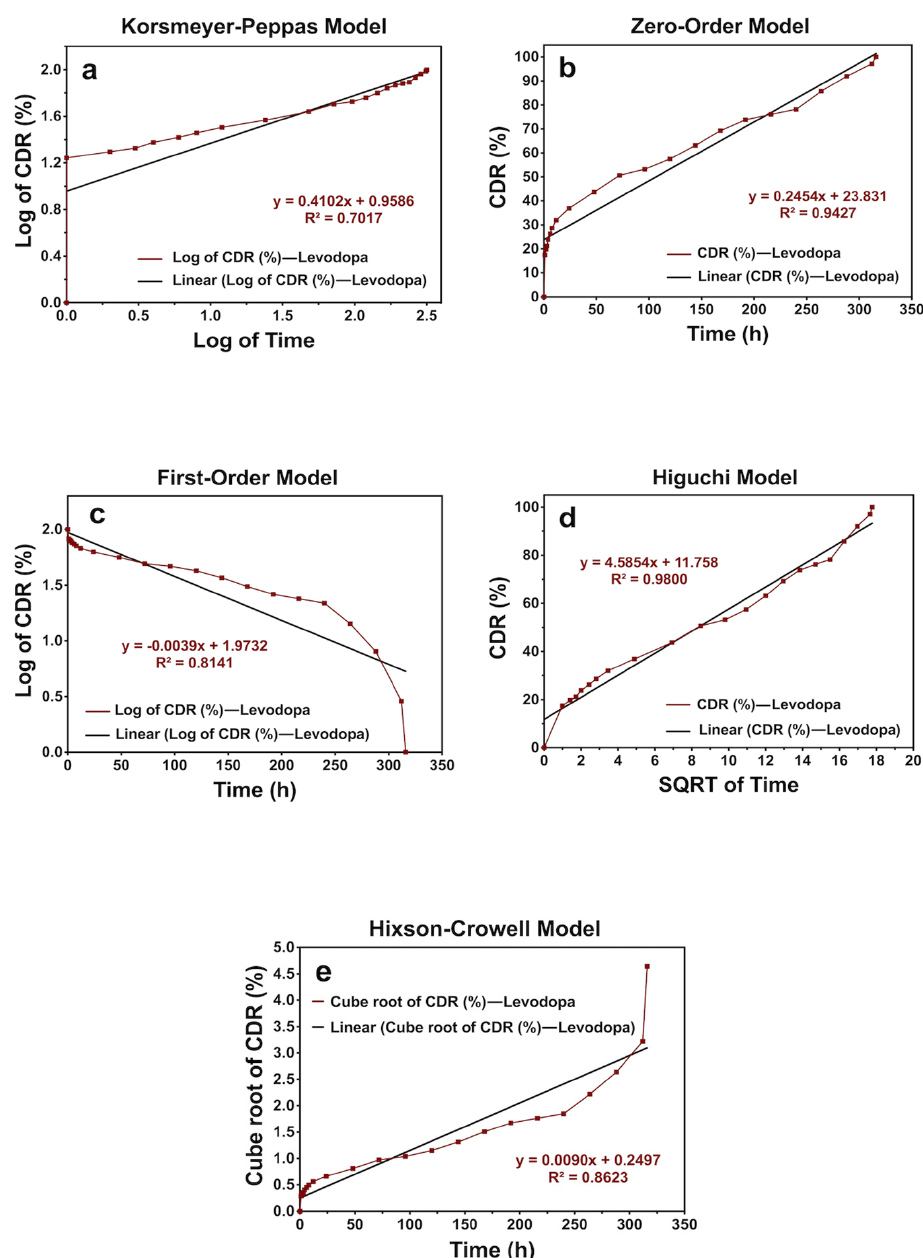
Figure 7. The release kinetic models of levodopa release profiles from the scaffolds that have the concentration of levodopa at 0.03 mg/mL for 336 h: ( a ) Korsmeyer–Peppas, ( b ) zero-order, ( c ) first- order, ( d ) Higuchi, and ( e ) Hixson–Crowell models.